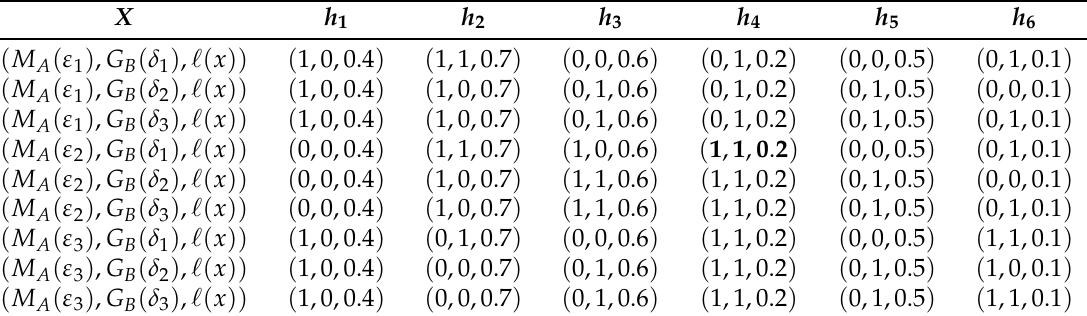
Table 1. Tabular representation of the makgeolli structure M ( A , B , U ) = ( M A , G B , (cid:96) ) . X h 1 h 2 h 3 h 4 h 5 h